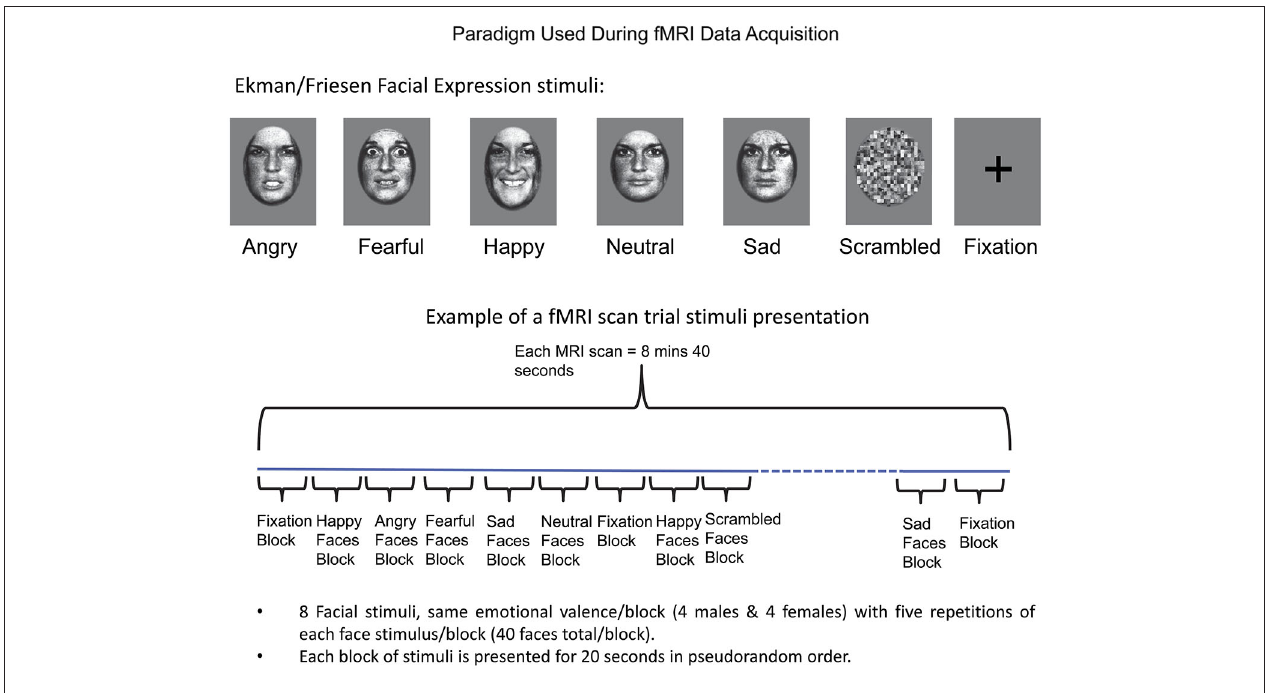
were presented as blocks is shown at bottom, along with details relating to number of stimuli used per block. See Methods Section for further detail.